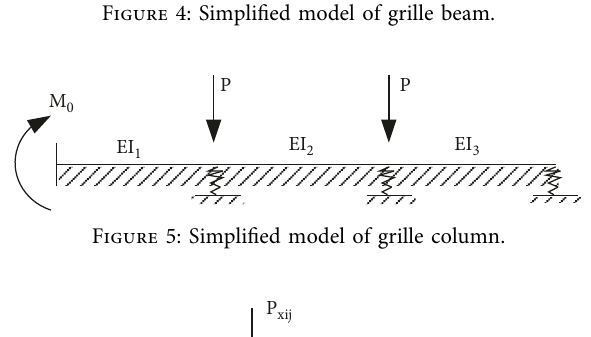
Figure 4: Simplified model of grille beam.